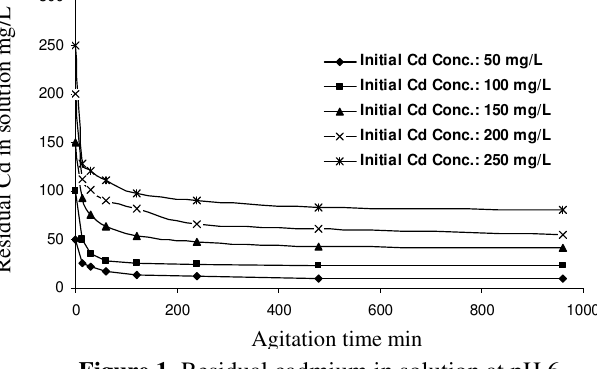
Figure 1. Residual cadmium in solution at pH